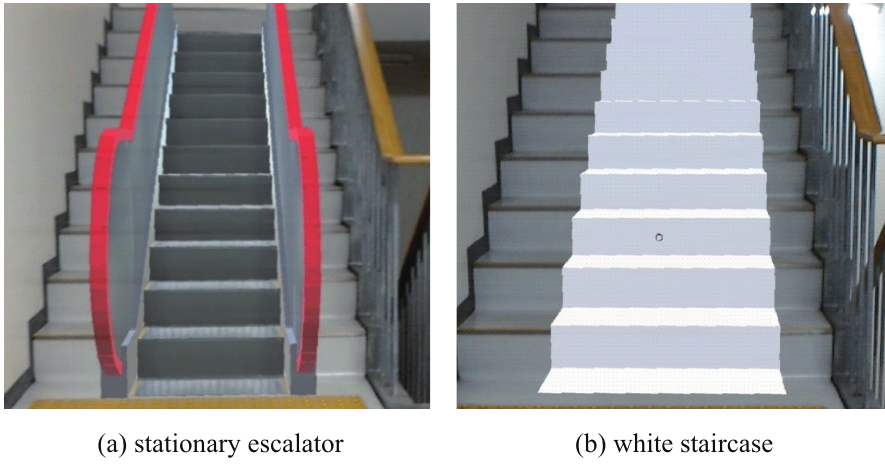
Figure 13. Appearances of augmented reality (AR) textures on the stairs.